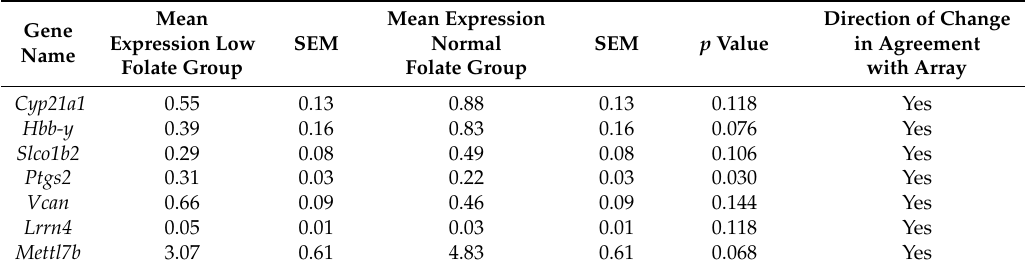
Table 9. RT-qPCR expression analysis of selected genes which were differentially expressed in placenta in response to maternal folate depletion 1,2 when assayed by microarray. Expression values are in arbitrary units calculated using the delta cycle threshold (CT) method. GAPDH was used as the reference gene. Expression levels were quantified in individual fetuses ( n = 18 per group) with mean expression levels calculated for individuals litters ( n = 6 per group) for use in statistical analyses to match procedures used for array